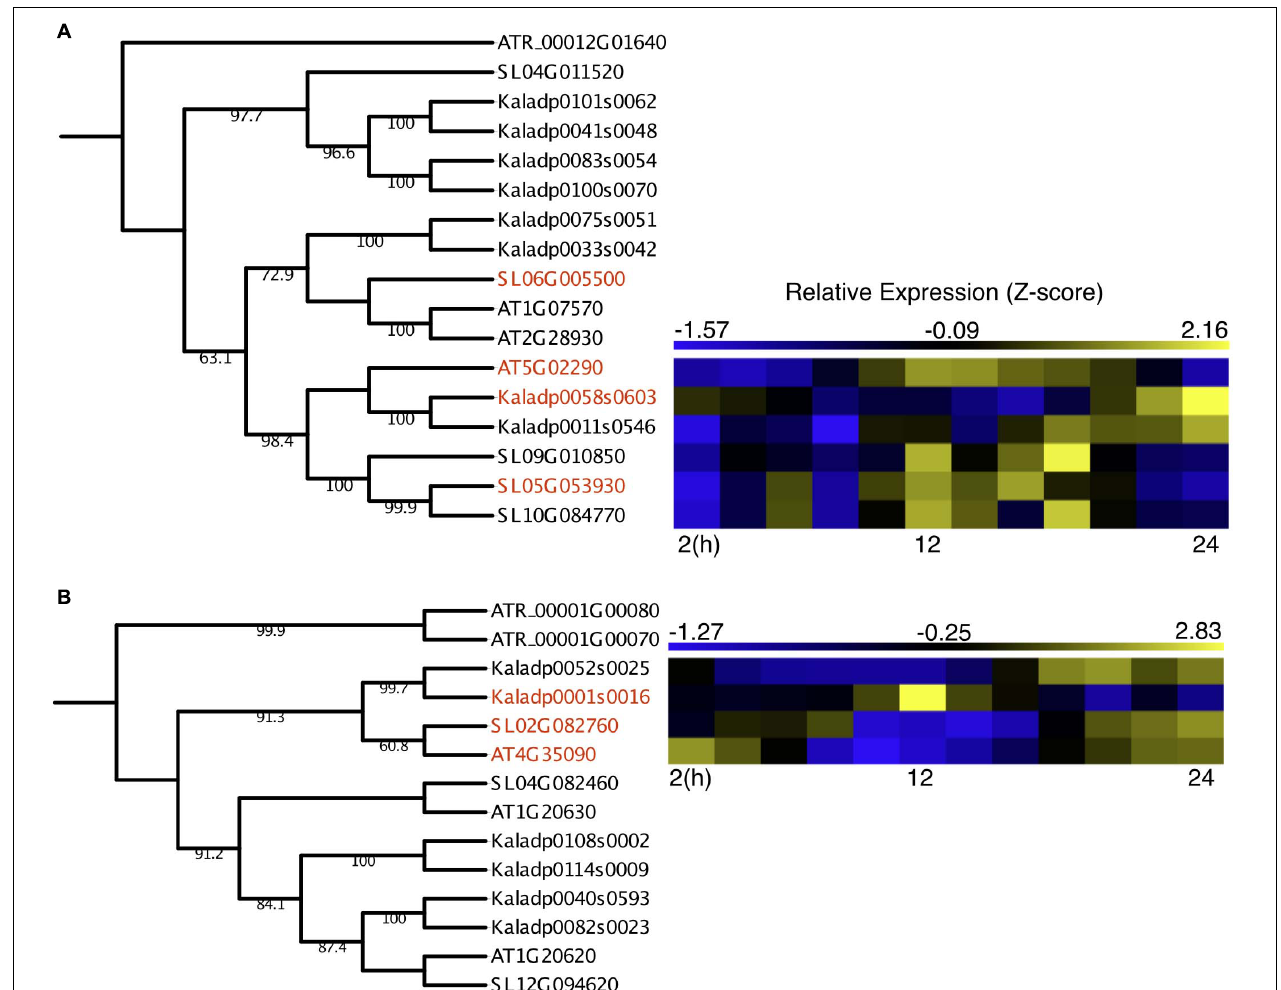
FIGURE 3 | Rescheduled diel expression of stomata-related genes in a CAM photosynthesis species ( K. fedtschenkoi ) in comparison with two C 3 photosynthesis species ( A. thaliana and S. lycopersicum ). (A) Phylogenetic tree of protein kinase genes and expression heatmaps of NAK genes in A. thaliana , S. lycopersicum , and K. fedtschenkoi . (B) Phylogenetic tree of catalase genes and expression heatmaps of CAT2 genes in A. thaliana , S. lycopersicum , and K. fedtschenkoi . Gene names in red text indicate genes found to be enriched in either dawn or